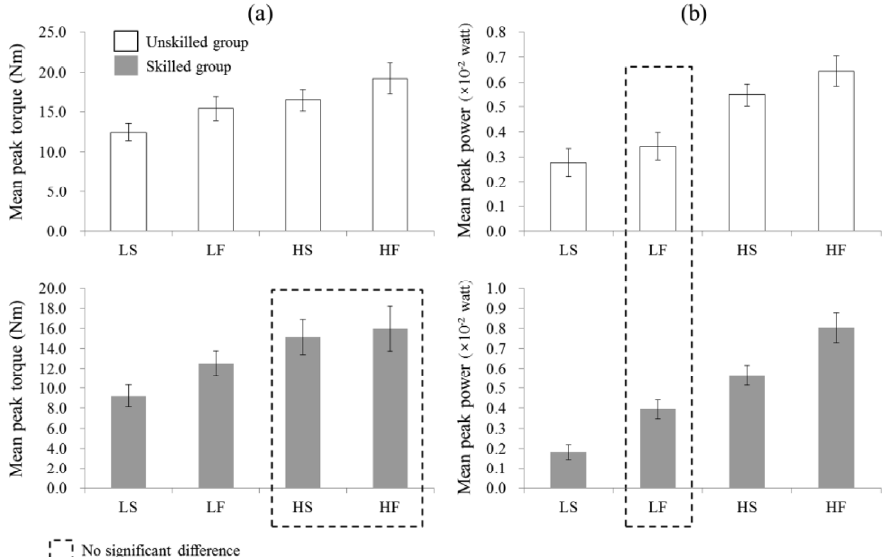
Figure 6. Mean maximum propulsion (a) torques and (b) powers during manual wheelchair propulsion under four different conditions. They had all significant differences except the values in dotted